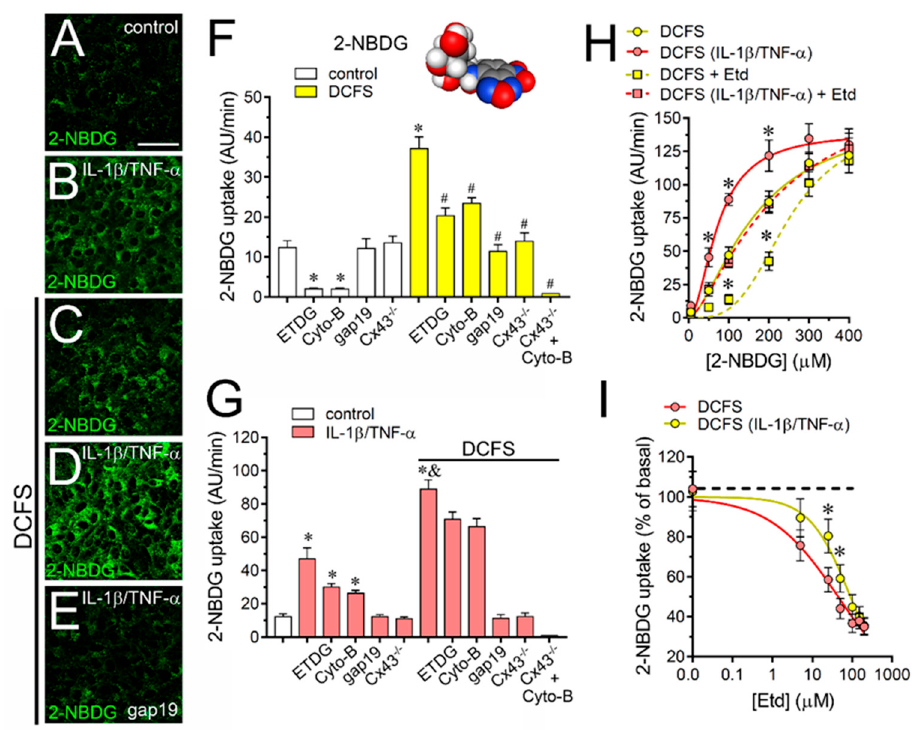
Figure 6. IL-1 β plus TNF- α modifies permeation features of 2-NBDG glucose through Cx43 hemichannels in cultured astrocytes. ( A – E ) Representative fluorescence images depicting 2-NBDG staining from dye uptake measurements (10 min exposure to 100 µ M 2-NBDG) in astrocytes under control conditions ( A ), after treatment with IL-1 β / TNF- α ( B ), or bathed with DCFS under control conditions ( C ), or after 24 h of treatment with IL-1 β / TNF- α alone ( D ) or plus 100 µ M gap19 ( E ). ( F ) Averaged 2-NBDG uptake rate of astrocytes bathed with control saline (white bars) or DCFS (yellow bars). Cells were exposed for 10 min to 100 µ M 2-NBDG. It is also shown the response of astrocytes knock-out for Cx43 or the impact of the following pharmacological agents: 100 mM ETDG, 100 µ M Cyto-B, 100 µ M gap19 or 100 µ M Tat-L2. * p < 0.05, treatments vs. control; # p < 0.05, pharmacological agents vs. DCFS (two-way ANOVA followed by Tukey’s post hoc test). ( G ) Averaged 2-NBDG uptake rate by control (white bars) or IL-1 β / TNF- α -treated (red bars) astrocytes bathed with normal saline or DCFS. Cells were exposed for 10 min to 100 µ M 2-NBDG. It is also shown the response of astrocytes knock-out for Cx43 or the impact of the following pharmacological agents: 100 mM ETDG, 100 µ M Cyto-B, 100 µ M gap19 or 100 µ M Tat-L2. * p < 0.05, IL-1 β / TNF- α vs. control; & p < 0.05, IL-1 β / TNF- α vs. IL-1 β / TNF- α plus DCFS; # p < 0.05, pharmacological agents vs. IL-1 β / TNF- α plus DCFS (two-way ANOVA followed by Tukey’s post hoc test). ( H ) Relationship between 2-NBDG uptake rate and increasing concentrations of 2-NBDG by astrocytes bathed with DCFS under control conditions alone (yellow circles) or plus 150 µ M Etd (yellow squares); or after treatment with IL-1 β / TNF- α alone (red circles) or plus 150 µ M Etd (red squares). Data were fitted using an empirical equation for sigmoidal binding-velocity curves (see methods). * p < 0.05, control DCFS vs. treatments (two-way ANOVA followed by Tukey’s post hoc test). ( I ) 2-NBDG uptake rate normalized to the maximum e ff ect evoked by DCFS in control (yellow circles) or IL-1 β / TNF- α -treated (red circles) astrocytes exposed to increasing concentrations of Etd. Data were fitted using the [inhibitor] vs. normalized response variable slope regression (see methods). * p < 0.05, control DCFS vs. IL-1 β / TNF- α DCFS (two-way ANOVA followed by Tukey’s post hoc test). Data were obtained from at least three independent experiments with four repeats for each one ( ≥ 25 cells analyzed for each repeat). Space-filling model for the atomic structure of 2-NBDG was elaborated with the MolView GPL software (carbon: gray, hydrogen: dark gray, and nitrogen: blue). Calibration bar: 20 µ